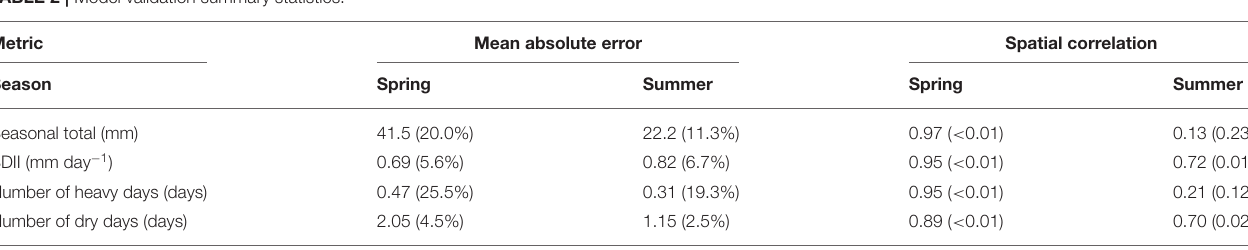
TABLE 2 | Model validation summary